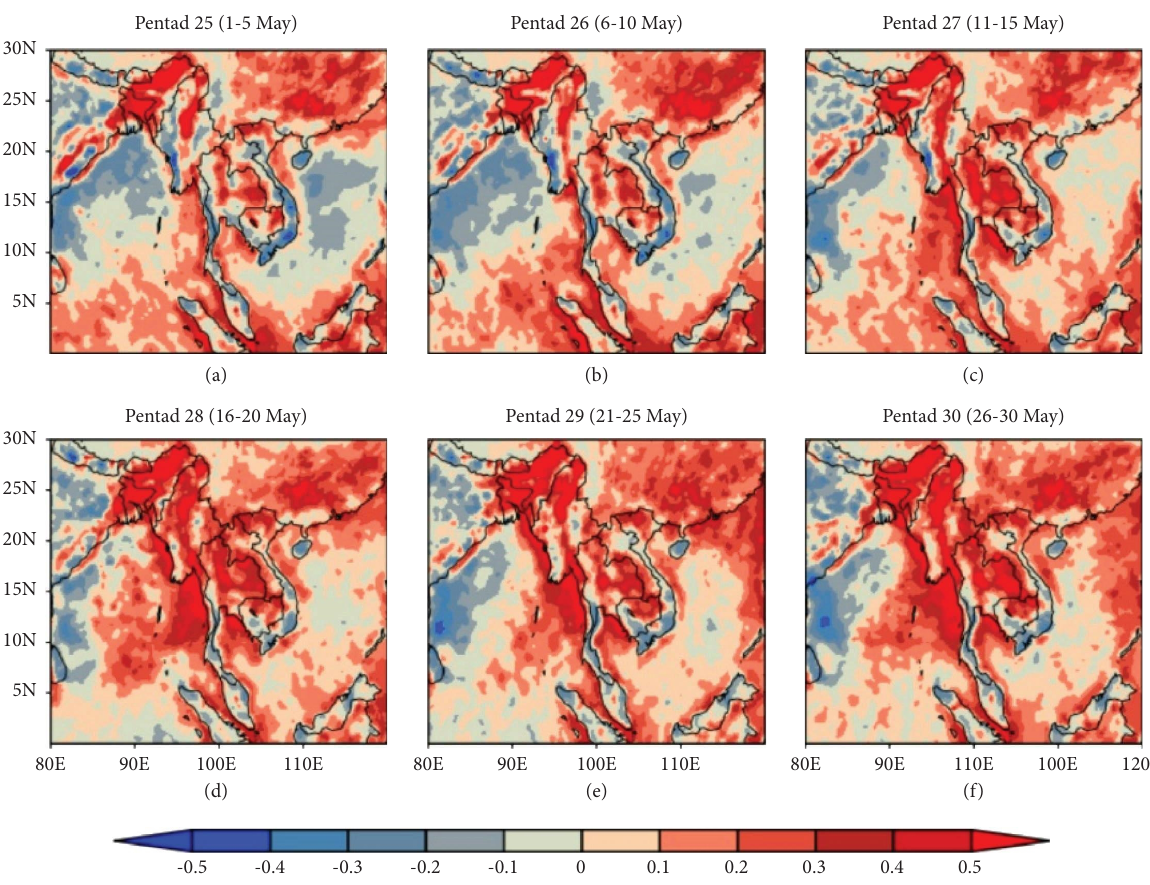
Figure 15: Composite of climatology (1991–2020) moisture convergence (kg · m − 2 · s − 1 , colour) during the pentads: (a) P -25 (May 1–5), (b) P -26 (May 6–10), (c) P -27 (May 11–15), (d) P -28 (May 16–20), (e) P -29 (May 21–25), and (f) P -30 (May 26–30) during the monsoon onset